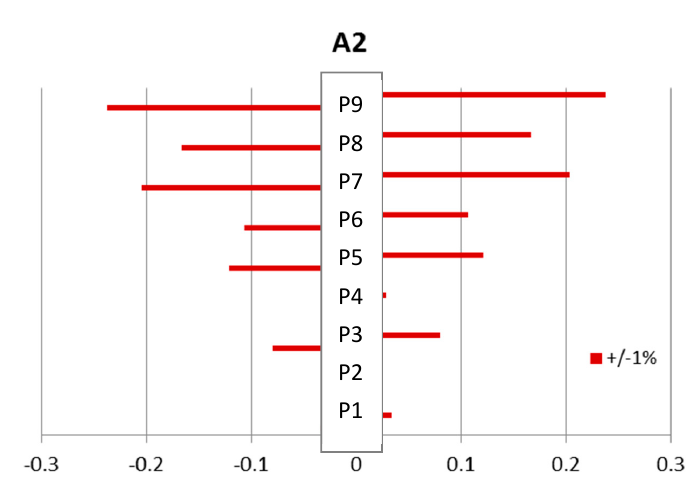
Figure 9. Sensitivity analysis of Alternative 2.